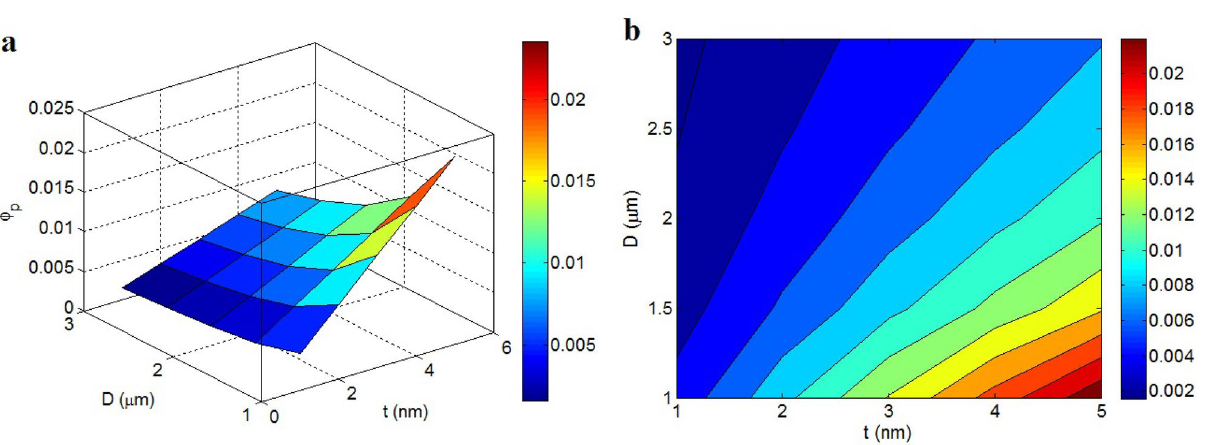
Figure 3. The percolation beginning by “t” and “D” (Eq. 7) at t i = 2 nm and d = 5 nm: ( a ) 3D and ( b ) 2D